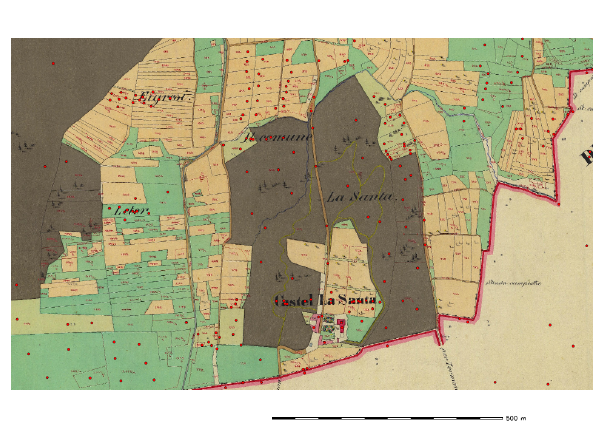
Figure 6. Training points (red dots) - particular.